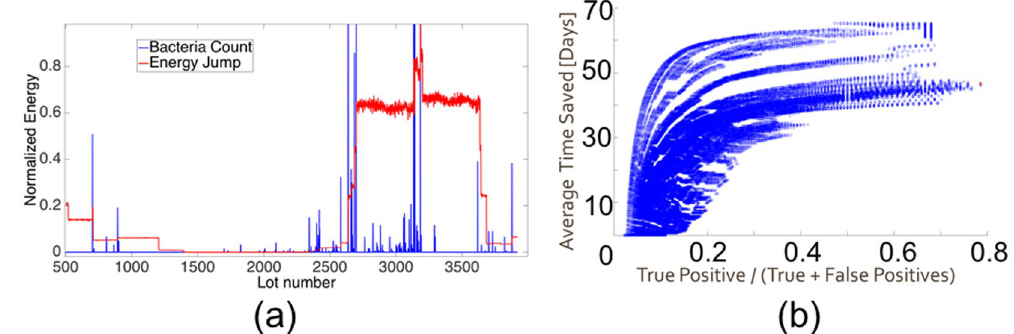
Figure 1. Energy Analysis. ( a ) Rosh Hayin 4 bacteria normalized count (blue) versus the corresponding normalized Energy jump (red); ( b ) Pareto Frontier, i.e., average time saved vs. true positives/(Total number of positives) for Rosh Hayin 7 well.